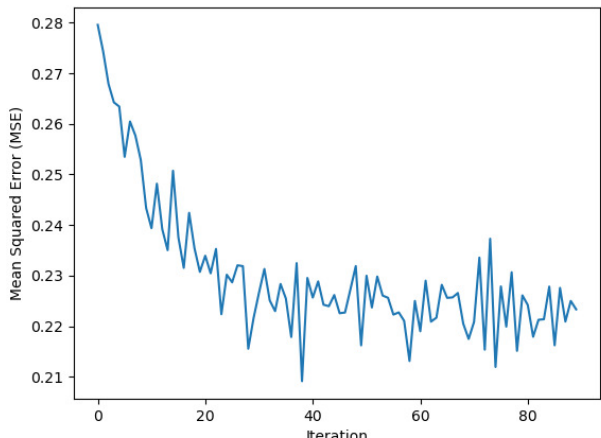
Figure 3. Training error in the second half using RMSprop.